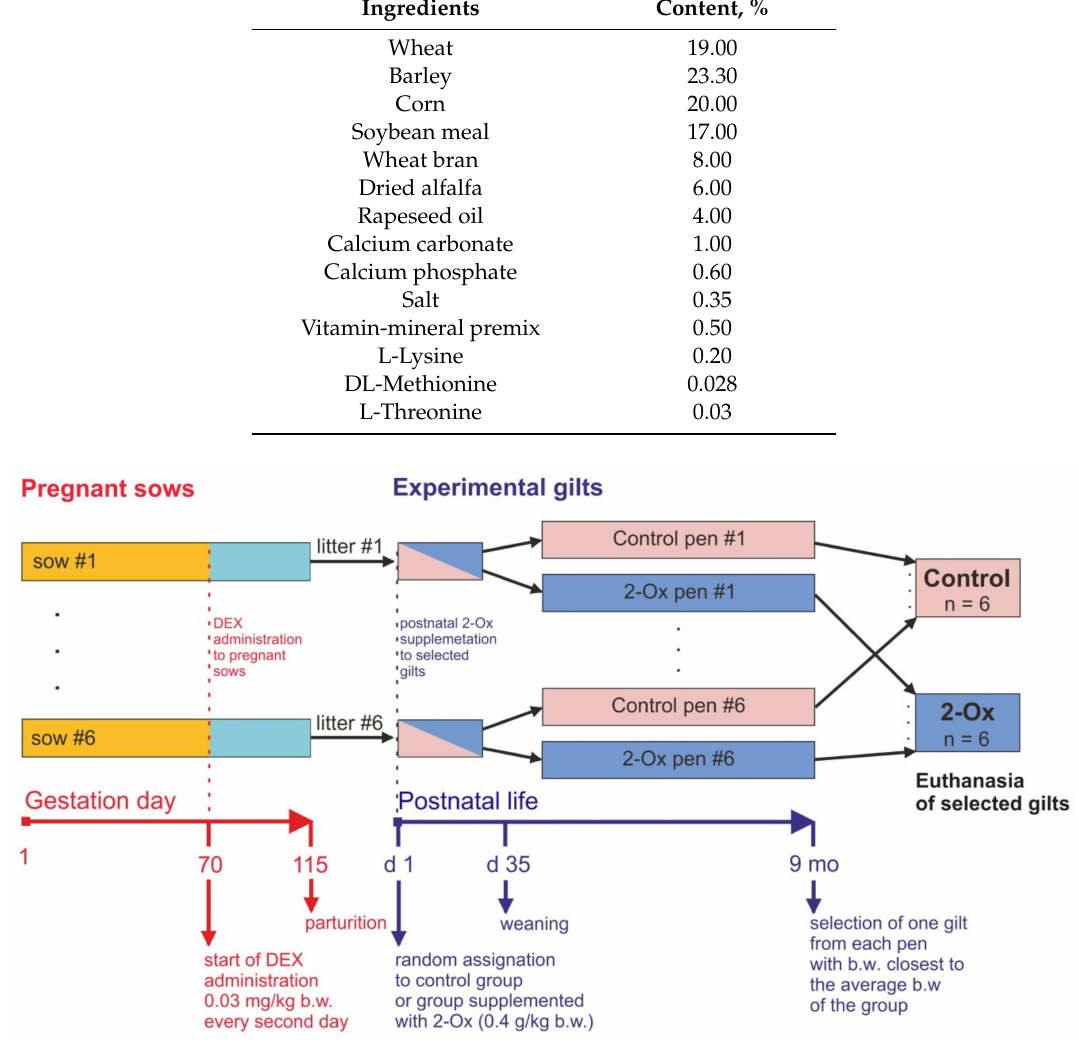
Figure 1. Scheme showing the experimental design. From the 70th day of gestation to parturition, dexamethasone (DEX) was administered to each sow at the dose of 0.03 mg / kg body weight (b.w.) every second day. After delivery, all newborn gilts were randomly assigned to one of the two experimental groups: the control group (not administered with 2-oxoglutaric acid (2-Ox)) or the group supplemented with 2-Ox with the dose 0.4 g / kg b.w. daily for nine months (2-Ox group). After weaning, the gilts were kept in group pens, with each litter in a separate pen. After final weighing at the age of nine months, one gilt from each litter / pen with a body weight closest to the average body weight of the experimental group was selected and